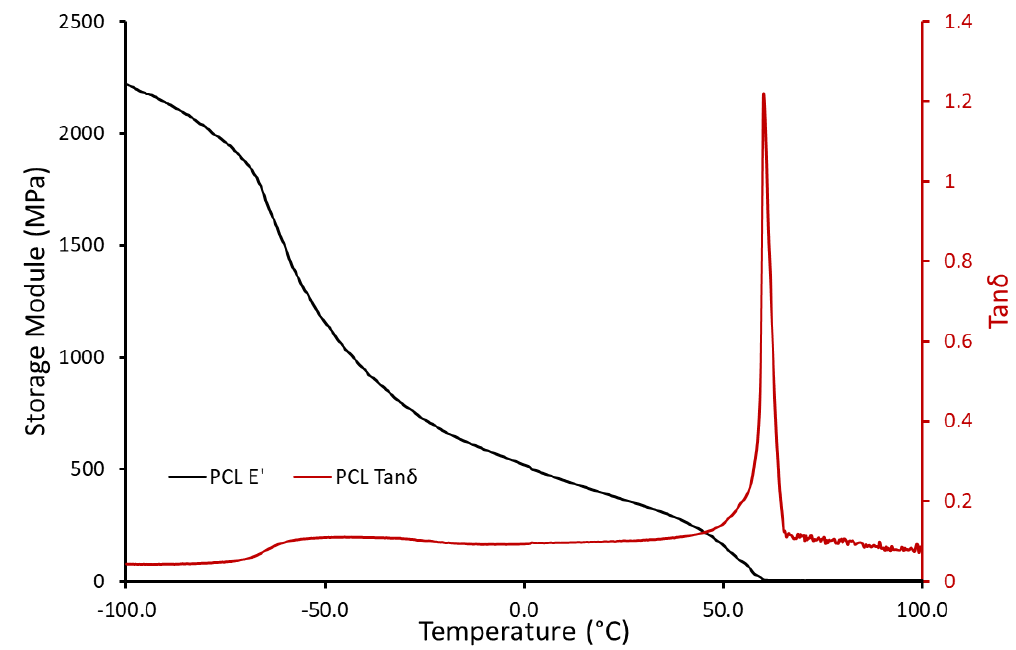
Figure 4. Storage module and tanδ of